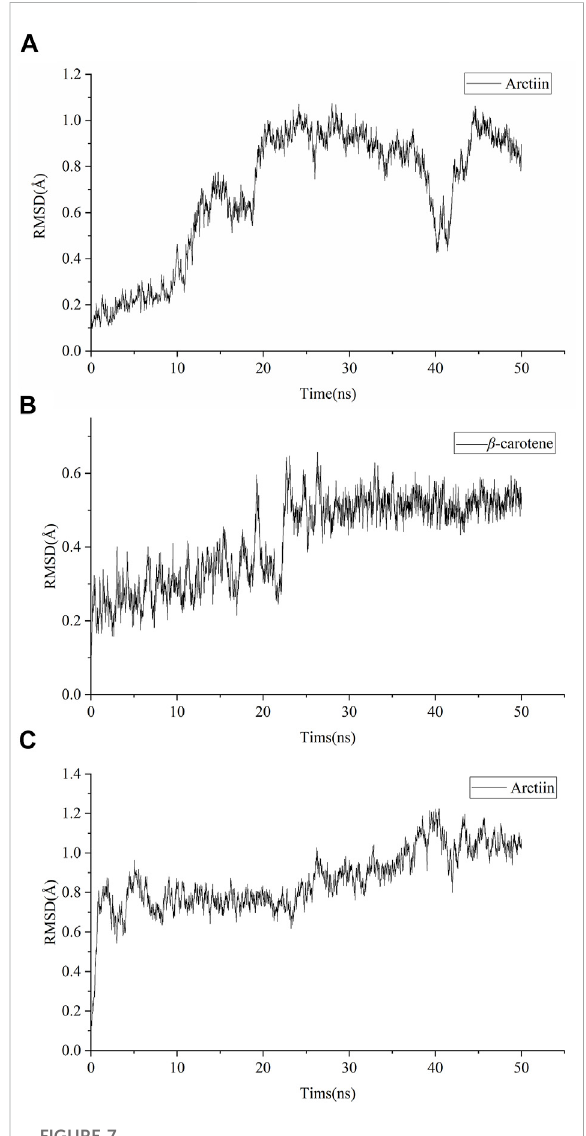
FIGURE 7 Root mean square deviation (RMSD) of molecular dynamic